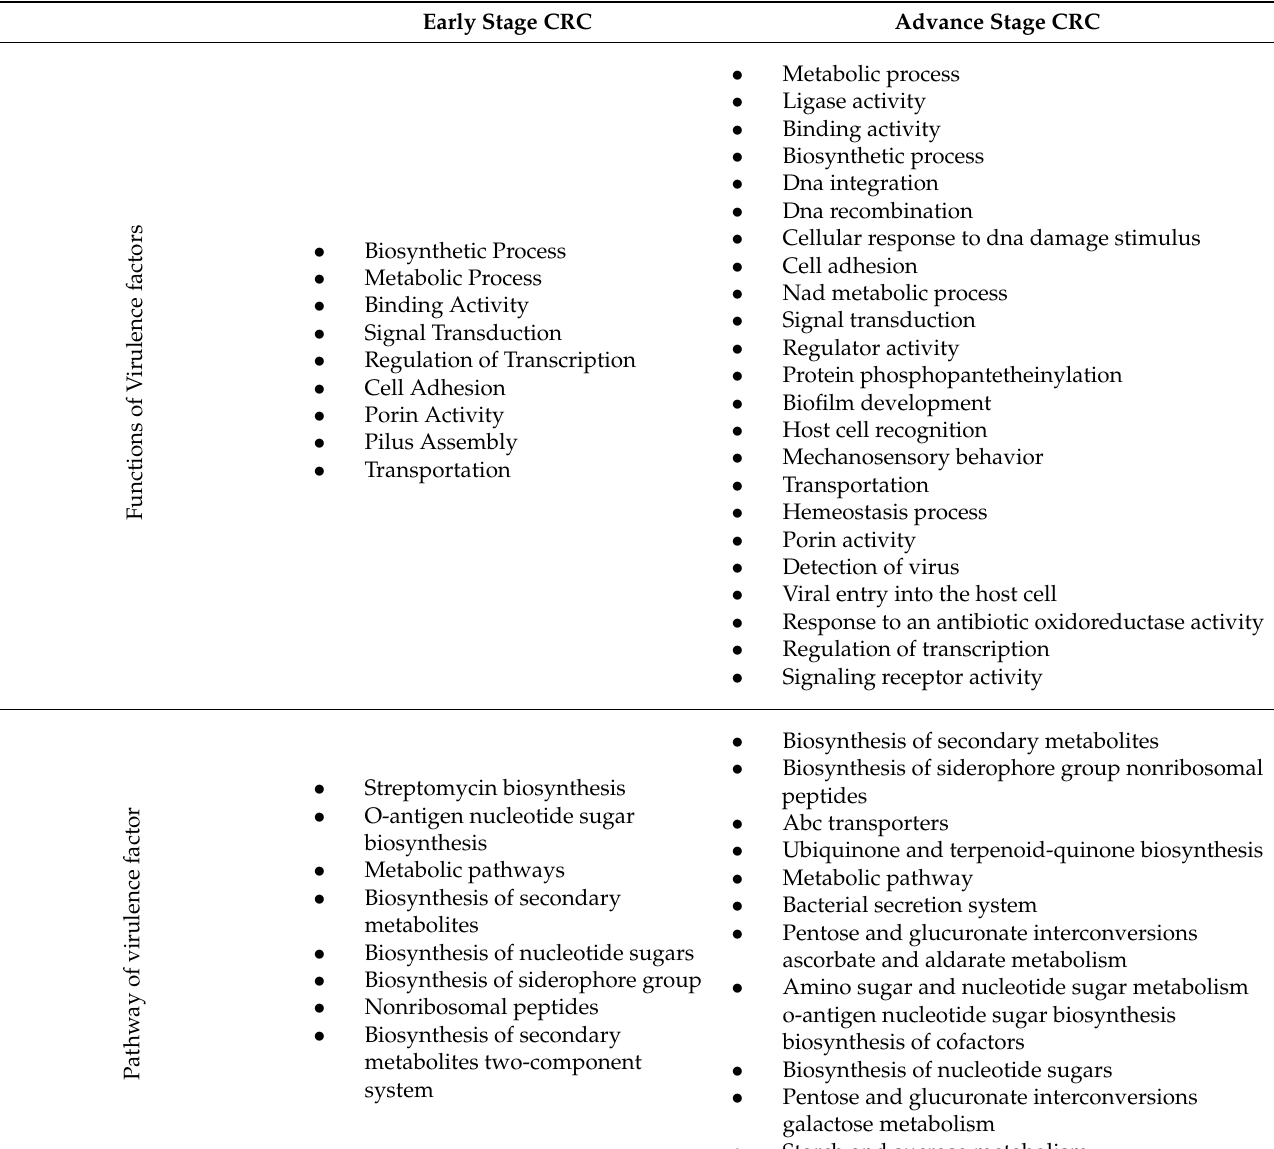
Table 2. Functions and pathway analysis of the VFs associated with different stages of CRC. Early Stage